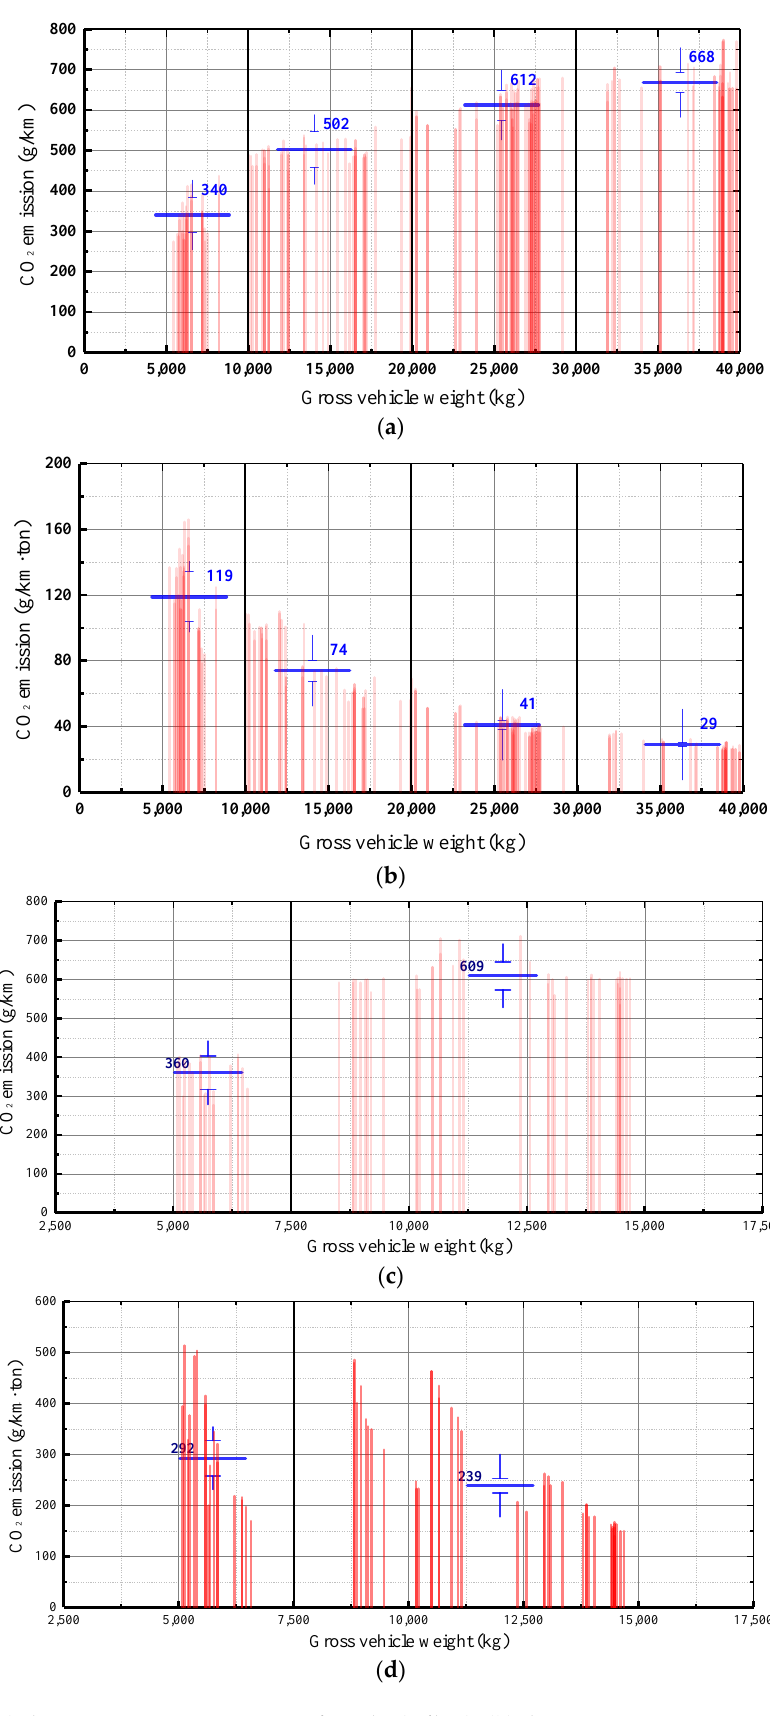
Figure 7. ( a ) the average CO 2 emissions of trucks (g/km); ( b ) the average CO 2 emissions of trucks (g/km∙ton); ( c ) the average CO 2 emissions of buses (g/km); and ( d ) the average CO 2 emissions of buses (g/km∙ton). buses (g/km ·